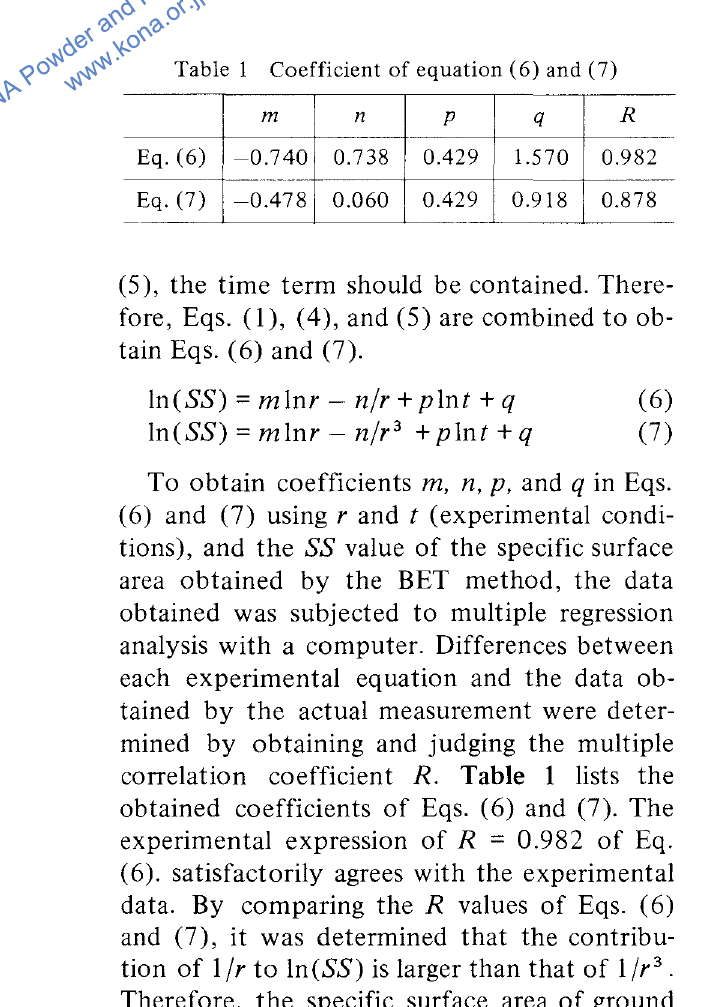
Table 1 Coefficient of equation ( 6) and (7)